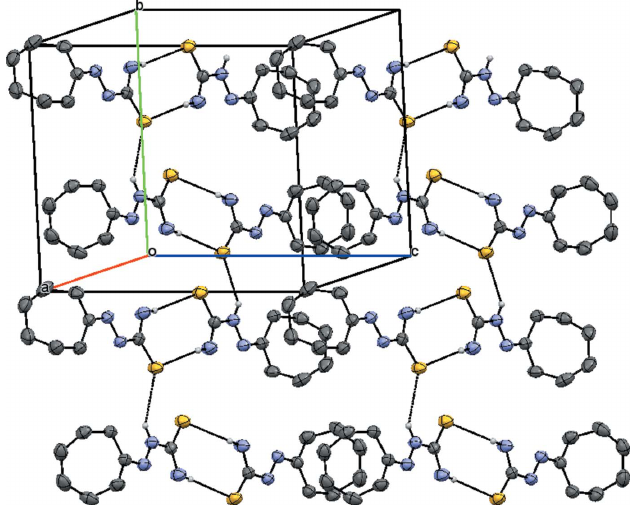
Figure 2 Part of the crystal structure, with hydrogen bonds shown as dotted lines.